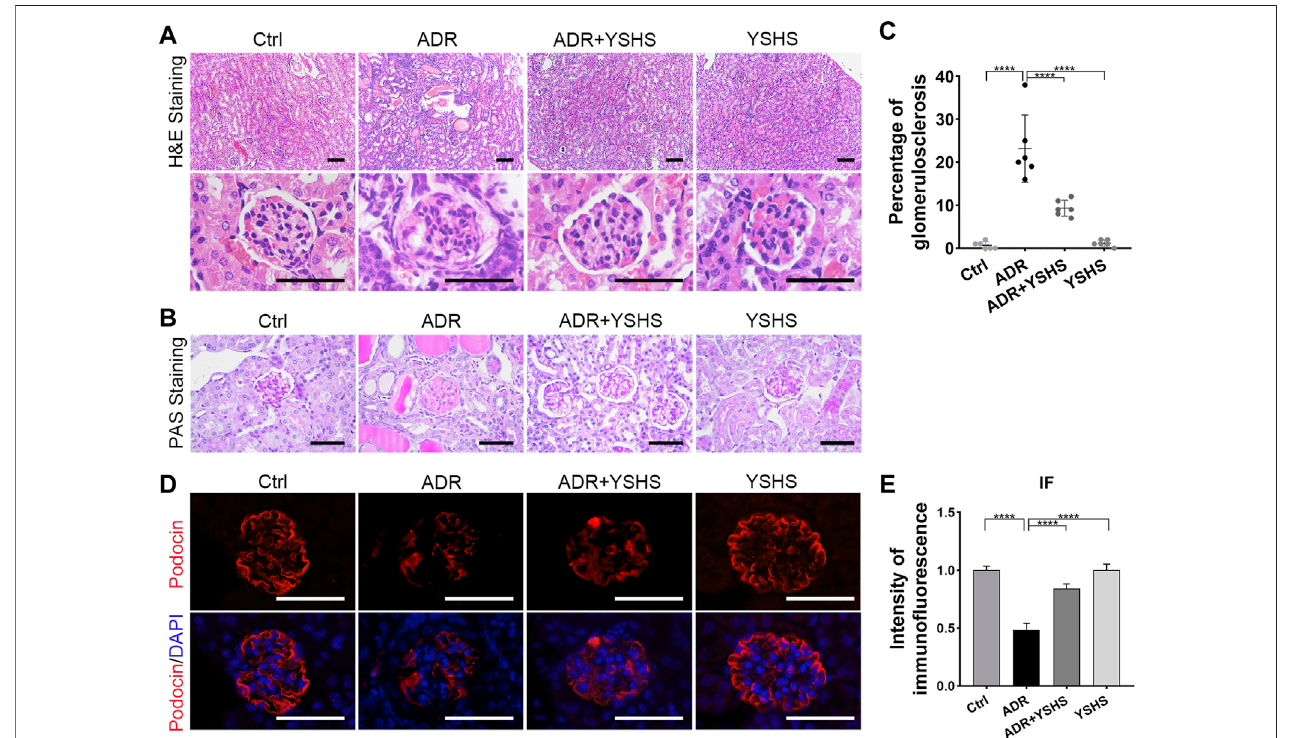
FIGURE 2 | YSHS granule ameliorates glomerular injury in the FSGS model. (A) Representative H&E staining of the renal sections in the indicated groups. (B) Representative PAS staining of the renal sections in the indicated groups. (C) The percentage of glomerulosclerosis in each group. (D) Representative IF staining of podocin(red) in the indicated groups. DAPI was used tovisualize the cell nucleus (blue). (E) The quanti fi cation of the intensity of podocin revealed that the YSHS granule signi fi cantly increased the expression of podocin in the glomeruli of the FSGS model. All glomeruli from one section of 6 mice in each group were analyzed and the data were shown asmean ± SD, one-way ANOVA analysis followed byTukey post-hoc tests as appropriate for multiple comparisons, **** p < 0.0001.scale bar: 50